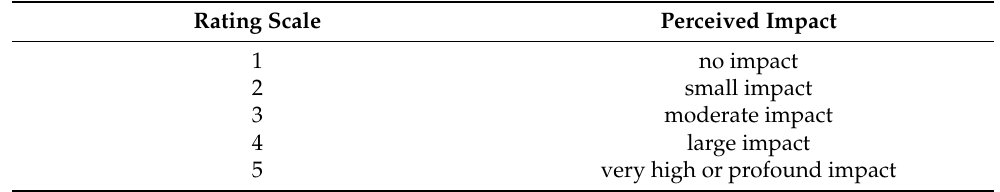
Table 3. Rating scale specifying the perceived impacts of smart health indictors.